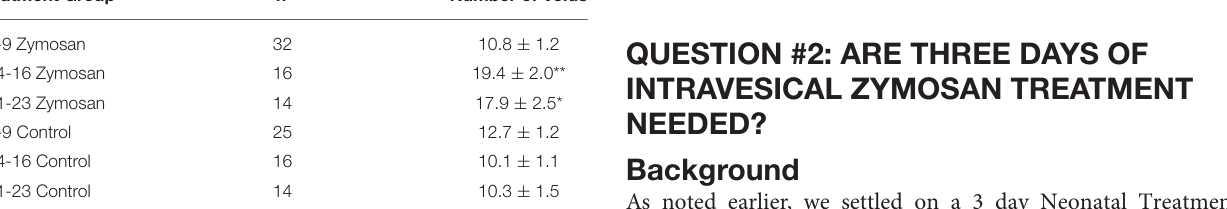
TABLE 1 | Voiding spot assay measures in adults female rats which received Early-In-Life (EIL) bladder treatments. Treatment Group